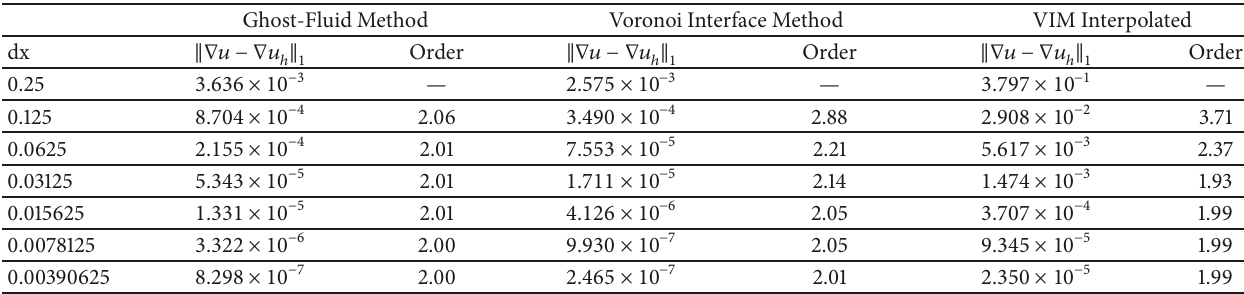
Table 4: Comparison of the 𝐿 1 error in the gradient of the solution for the Ghost-Fluid method and the Voronoi Interface Method, for example, shown in Section 3.1.